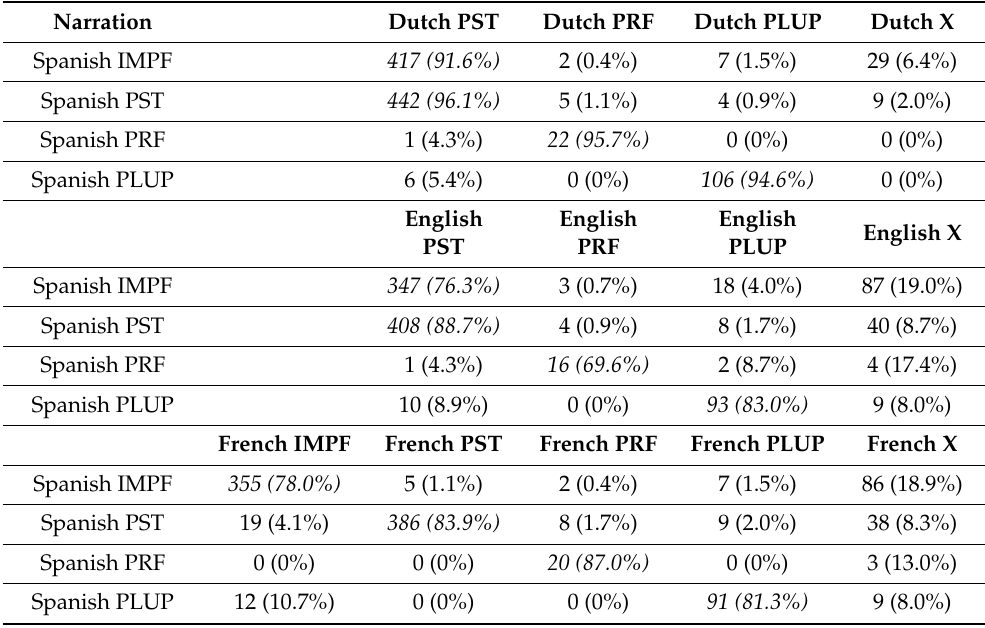
Table 1. Number of Spanish forms (rows) translated to Dutch, English, and French forms (columns) in narration, with the relative proportion in % between